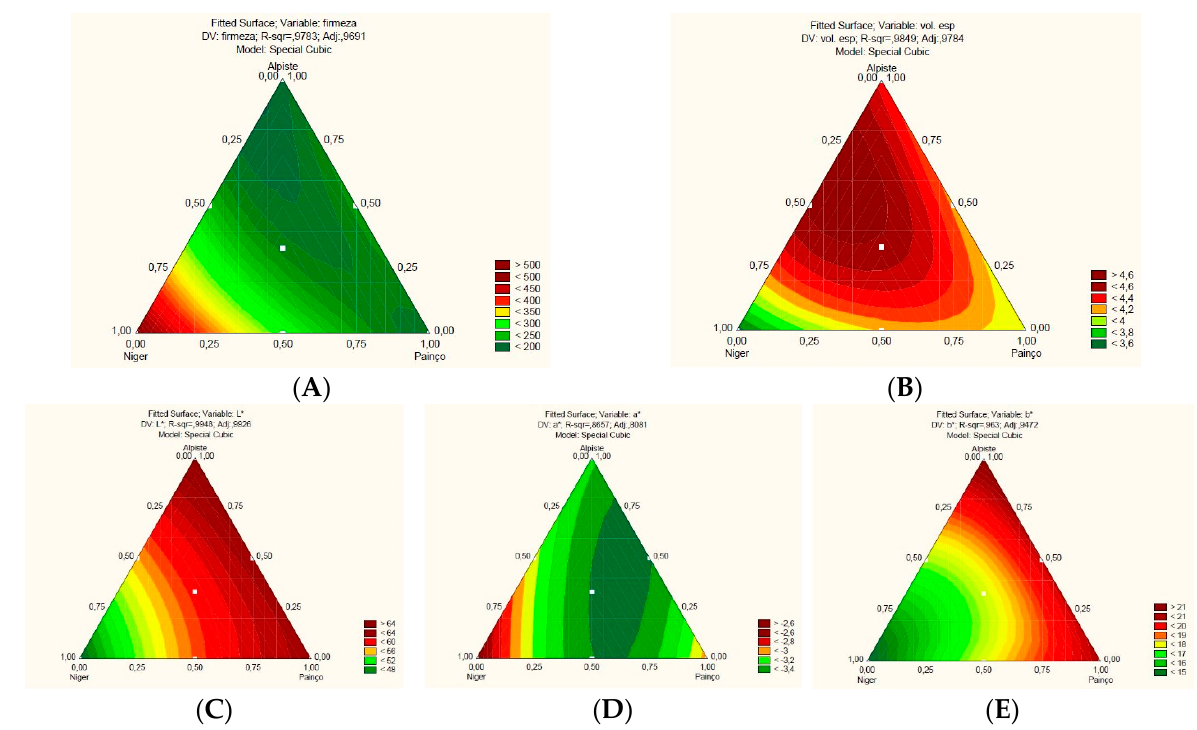
Figure 3. Area adjusted for the specific volume of bread ( A ); firmness ( B ) and color parameters for L ( C ), a* ( D ) and b* ( E ) of breadcrumbs containing different contents of niger, millet and birdseed. Experimental area defined by points and expressed in